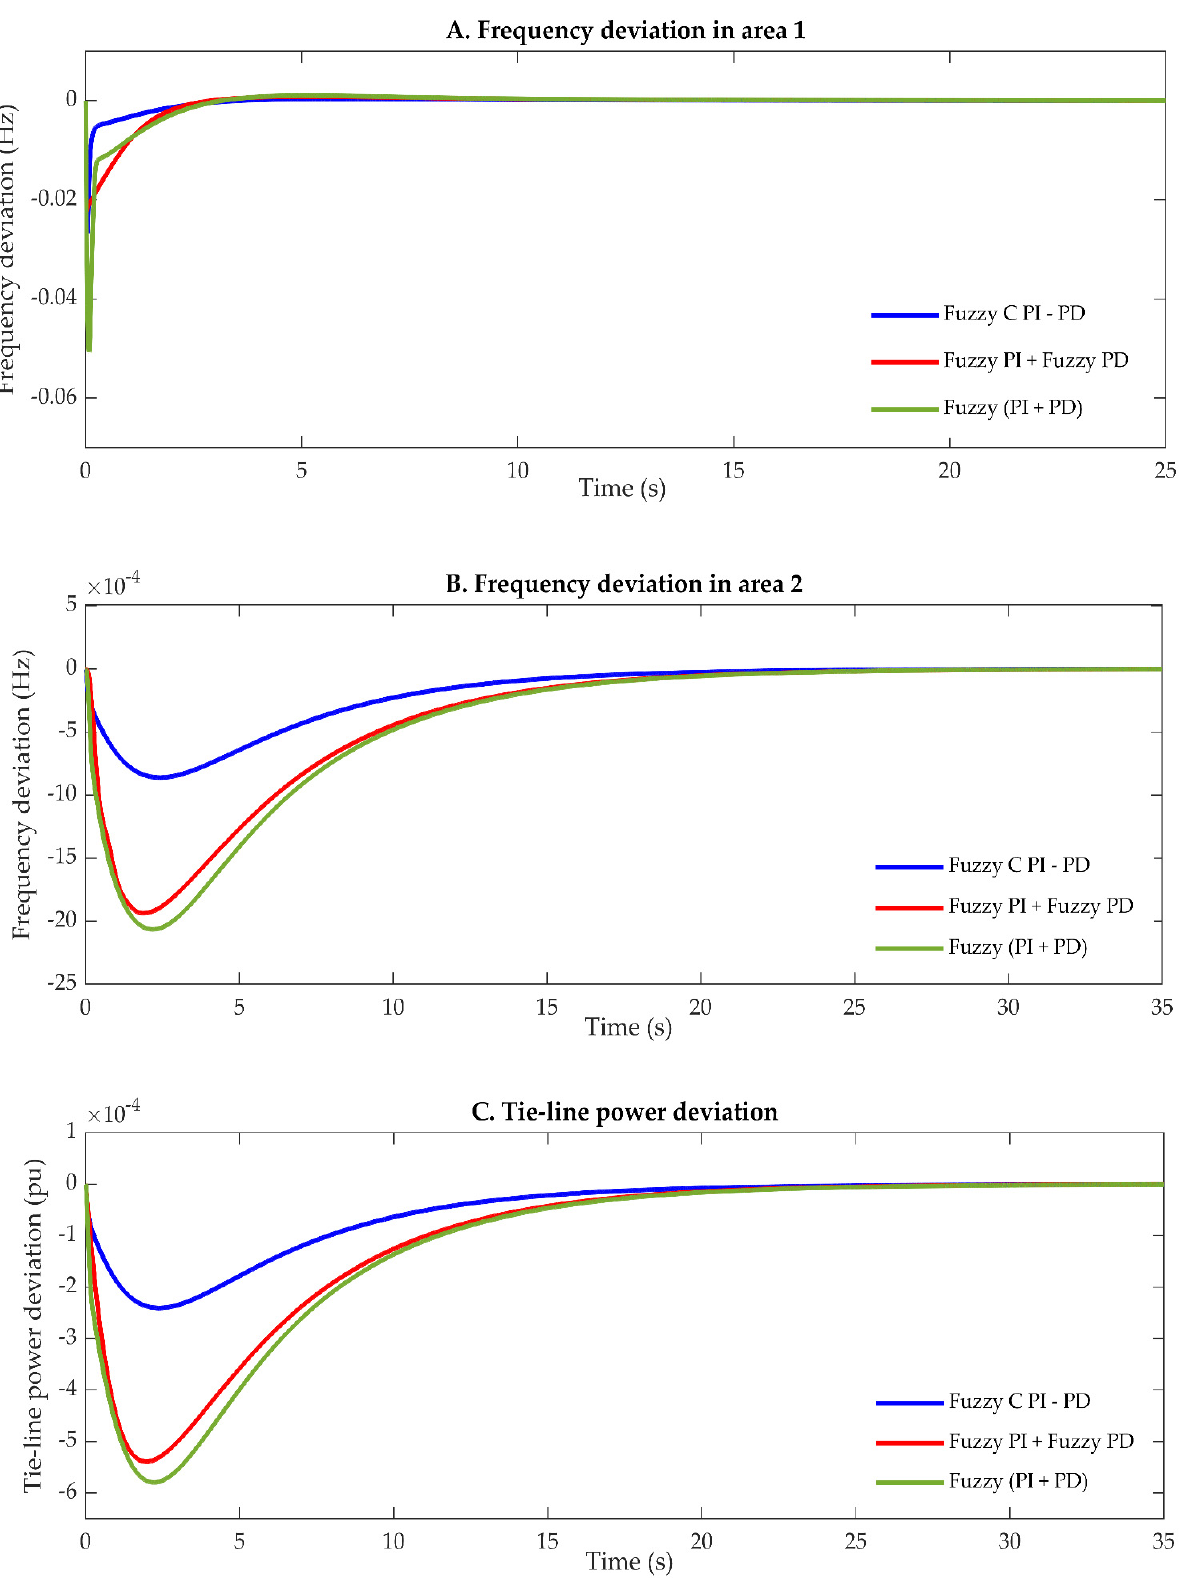
Figure 31. Dynamic response of the testbed power system based on different fuzzy controllers under parametric uncertainty conditions, case 10. ( A ) Frequency variation in area 1; ( B ) frequency variation in area 2; ( C ) tie-line power variation.